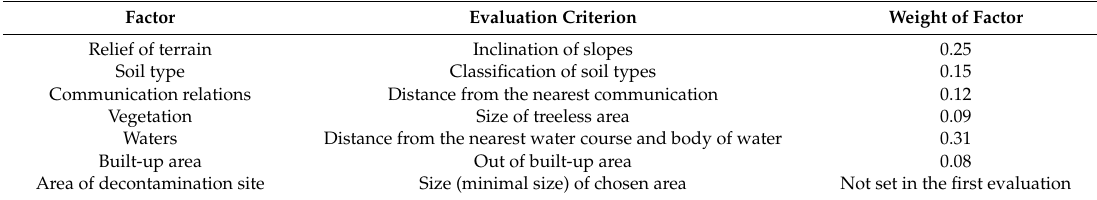
Table 2. Weights of factors and evaluation criteria.